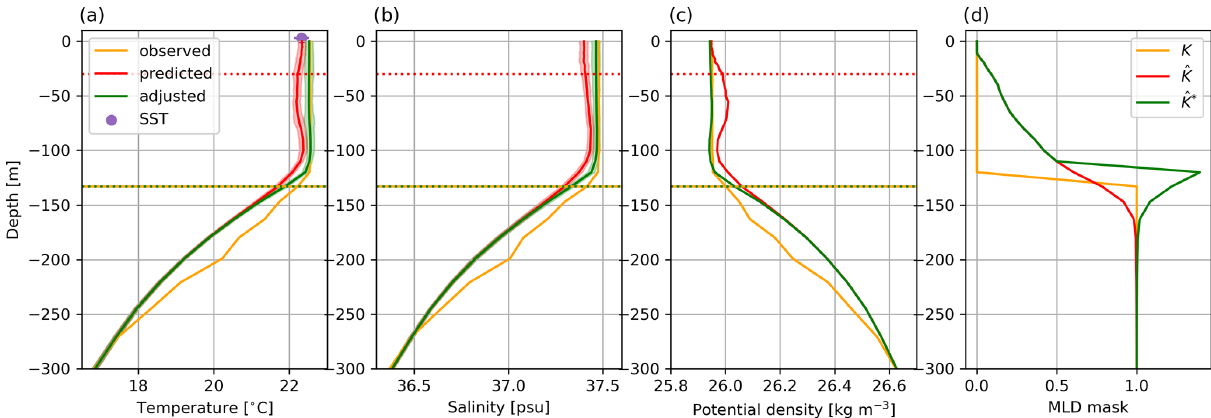
Figure 4. Example of a profile (orange) sampled on 3 March 2012 at 35.55 ◦ W and 23.53 ◦ N, truncated at 300m deep. We display tempera- ture (a) , salinity (b) , potential density (c) and profile K that is a mask of MLD (see Eq. 1). The T − S profile predicted by the NN is in red and the adjusted using the ˆ K ∗ profile (OSnet) in green (see Sect. 3.3). The green and red bands are the confidence interval for each profiles, i.e., the standard deviation of the 15 bootstrapped models. MLDs observed, predicted and adjusted are shown with dotted horizontal lines. SST is added with a purple dot and a horizontal bar for its mapping